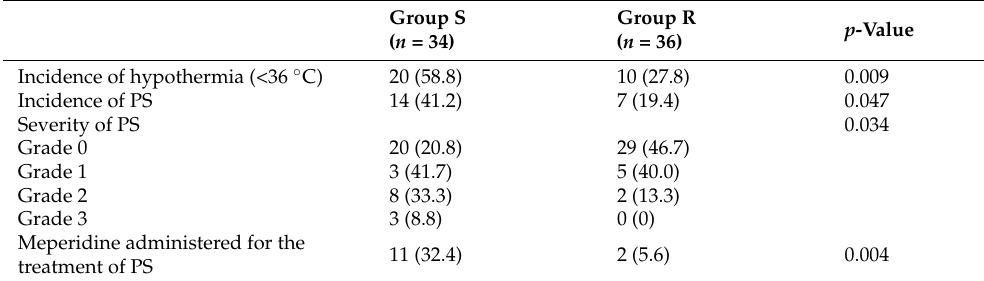
Group S Group R ( n = 34) ( n = 36) Group S Group R p -Value ( n = 34) ( n = 36)